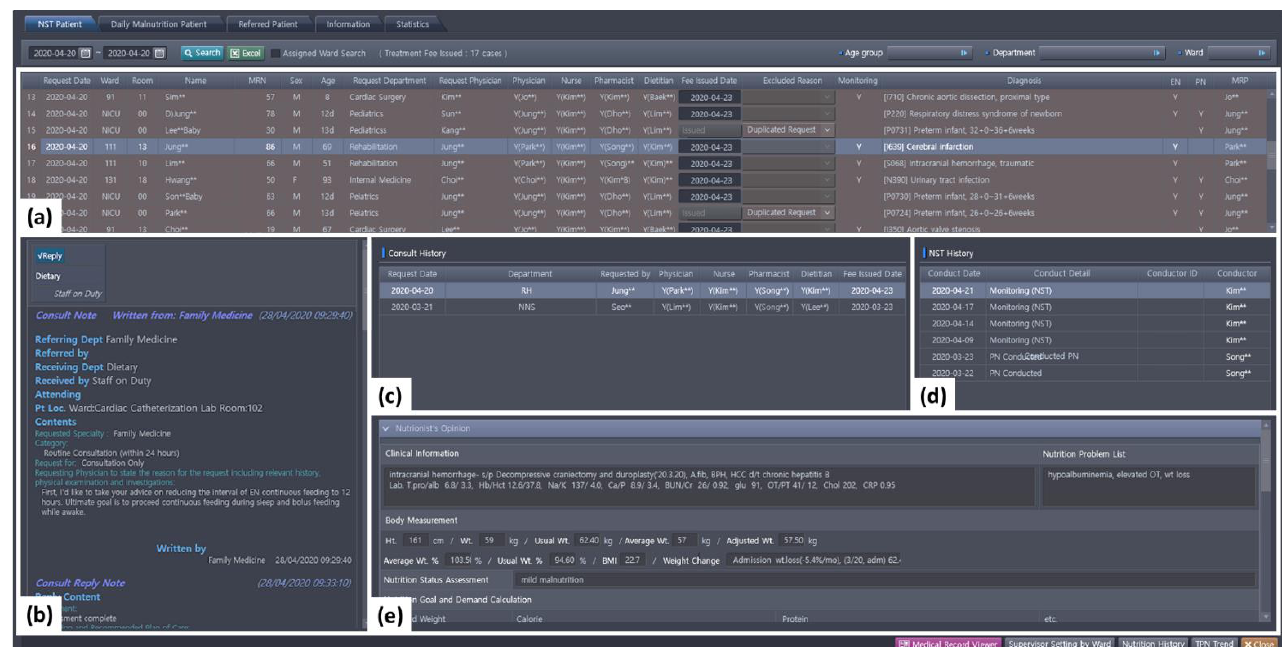
Figure 3. Nutrition support team (NST) patient management program at Seoul National University Bundang Hospital. The program enabled all NST members to share patient information and facilitated communication among team members. Each subsection of the screen represents the following: ( a ) list of referred patients and their information for nutrition support; ( b ) details of the referrals and responses from NST members; ( c ) NST referral history of the patient; ( d ) NST monitoring history of the patient; and ( e ) notes and opinions from NST members.